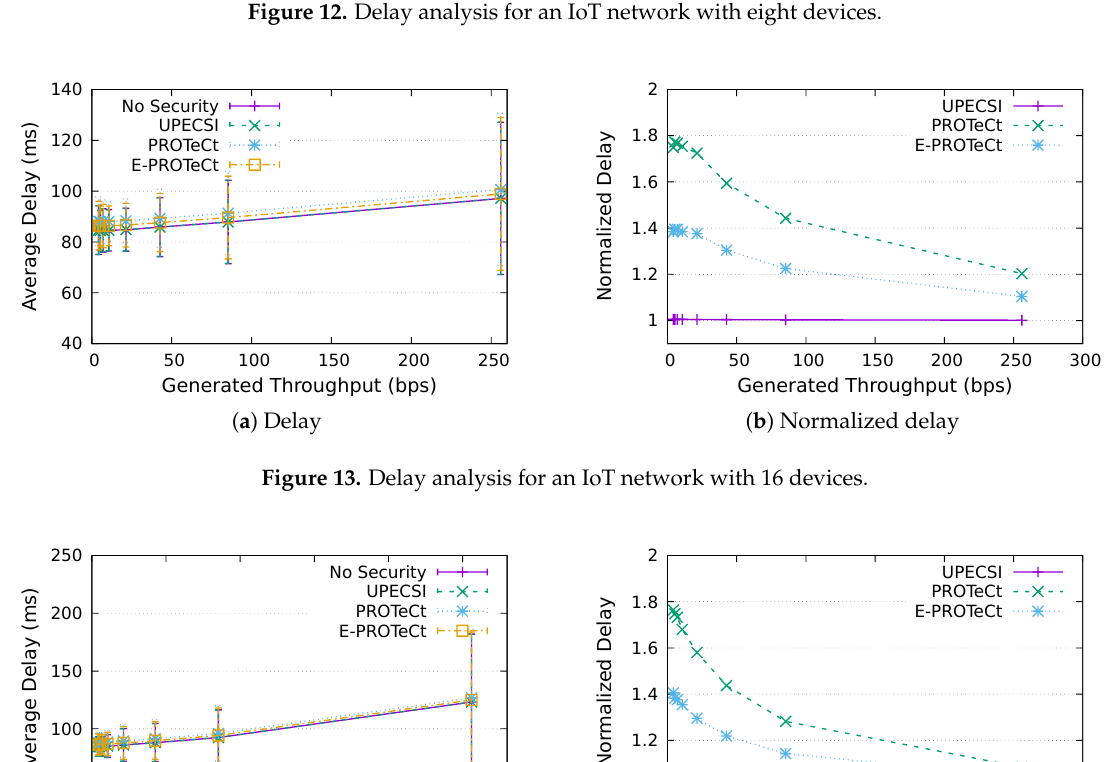
Figure 12. Delay analysis for an IoT network with eight devices.